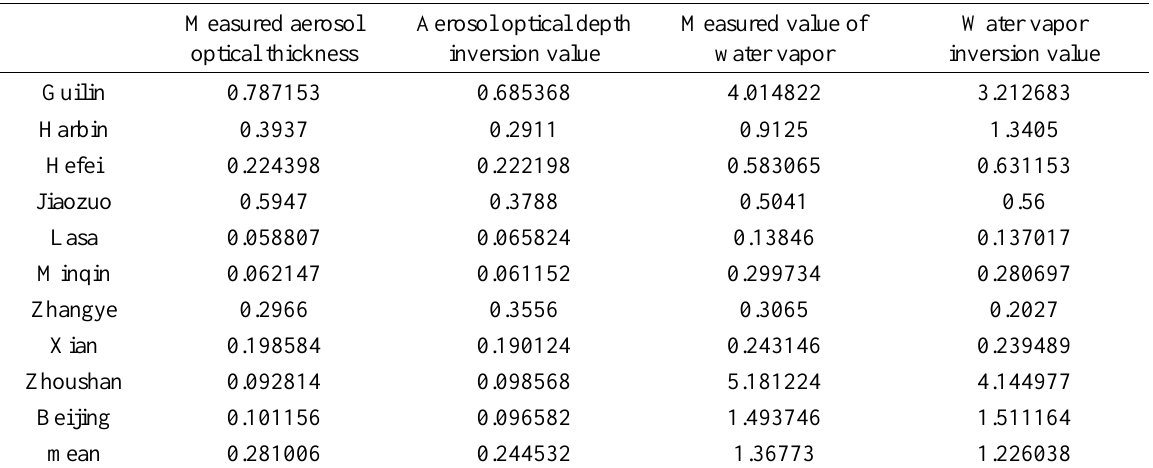
Table 4 . Accuracy verification of aerosol optical thickness and water vapor